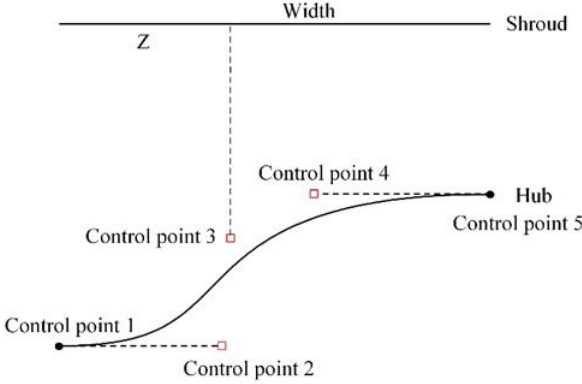
Figure 5. Meridian passage.